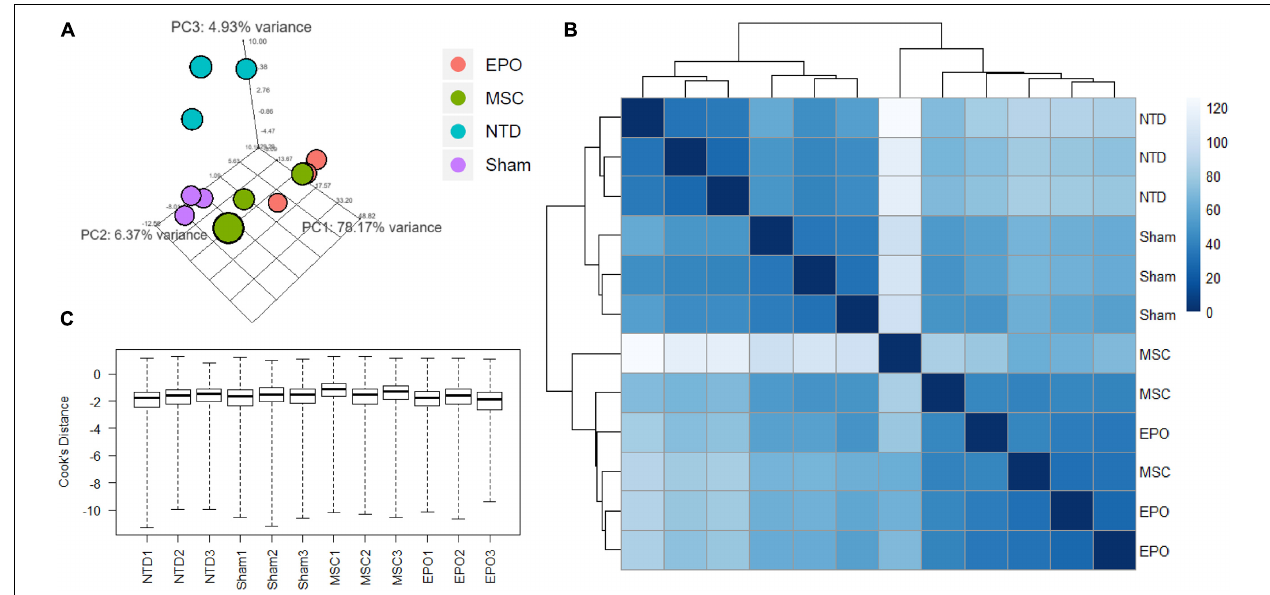
FIGURE 4 | Exploratory data analysis of RNA-Seq count data was performed by measuring sample distances to evaluate for similarities. (A) A principal component analysis (PCA) plot was constructed to show variances of principal components among all the samples. The no-treatment and sham-treated samples showed high intra-group similarities and thus formed 2 distinct groups. (B) Hierarchical clustering was performed using DESeq2 based on Poisson distance, and the data was plotted as a sample-to-sample heatmap. The colored indicator represents sample distances (blue signifies a high correlation). Here, the clustering of samples and groups was more differentiated. The MSC and MSC EPO groups showed a certain degree of similarity with each other. (C) A Cook’s distance boxplot was constructed to visualize the data after outlier detection and removal by DESeq2. NTD, no-treatment/healthy control; Sham, NaIO 3 -only/vehicle control; MSC, MSC-transplanted group; MSC EPO , MSC EPO -transplanted